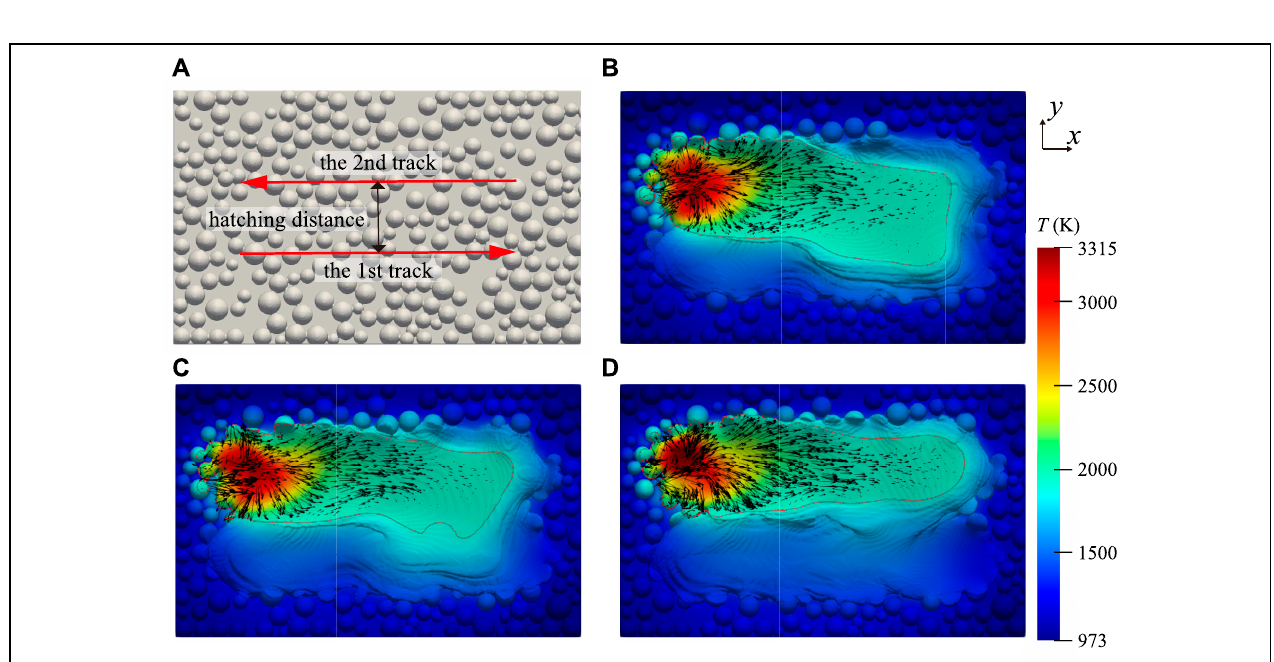
FIGURE 8 | (A) The scanning strategy (B−D) The temperature distribution of the melt pool with different hatching distance in the top view (B) : 0.28 mm, (C) : 0.32 mm, (D) : 0.36 mm.